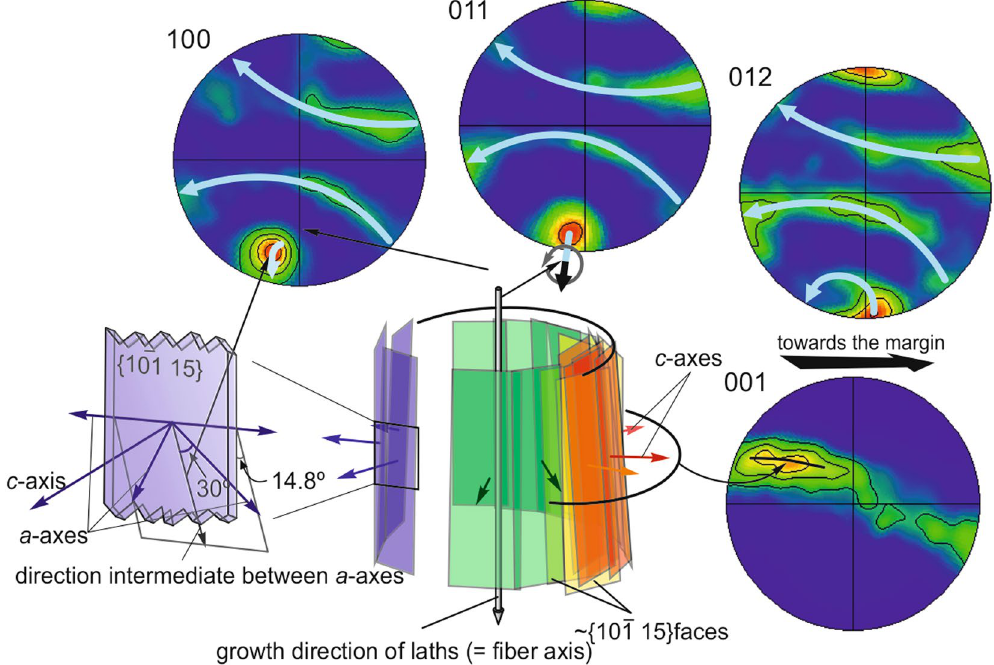
Figure 6. Crystallographic structure of the chalk, according to the distribution of pole maxima. Blades have a cylindrical distribution with the fibre axis being the growth axis of blades. These are in turn almost coincident with the 011 poles. Blades are more densely distributed in the direction of the margin. 100 and 001 pole figures adapted from Fig.